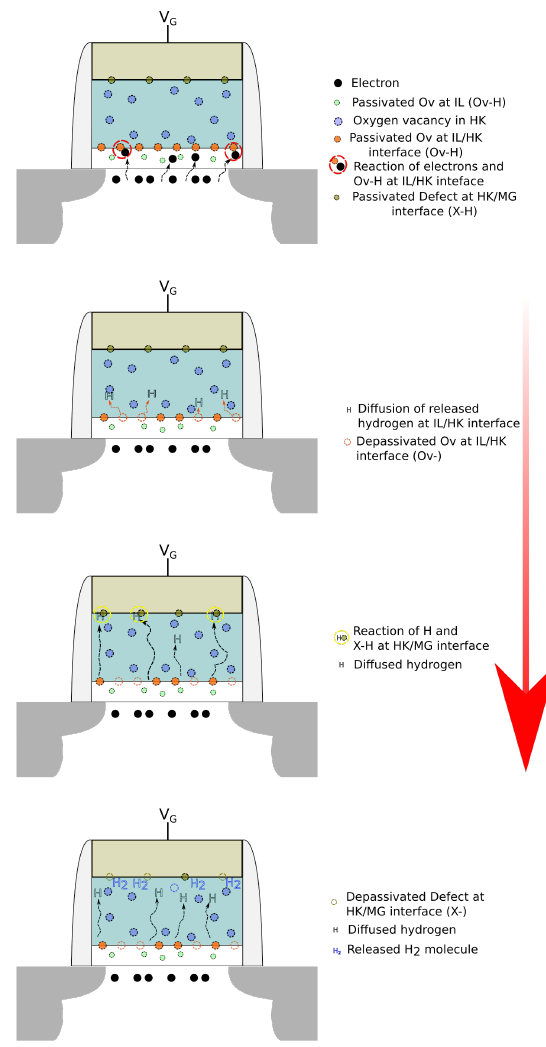
Figure 6. Degradation time evolution for PBTI interface traps’ generation. MG, metal